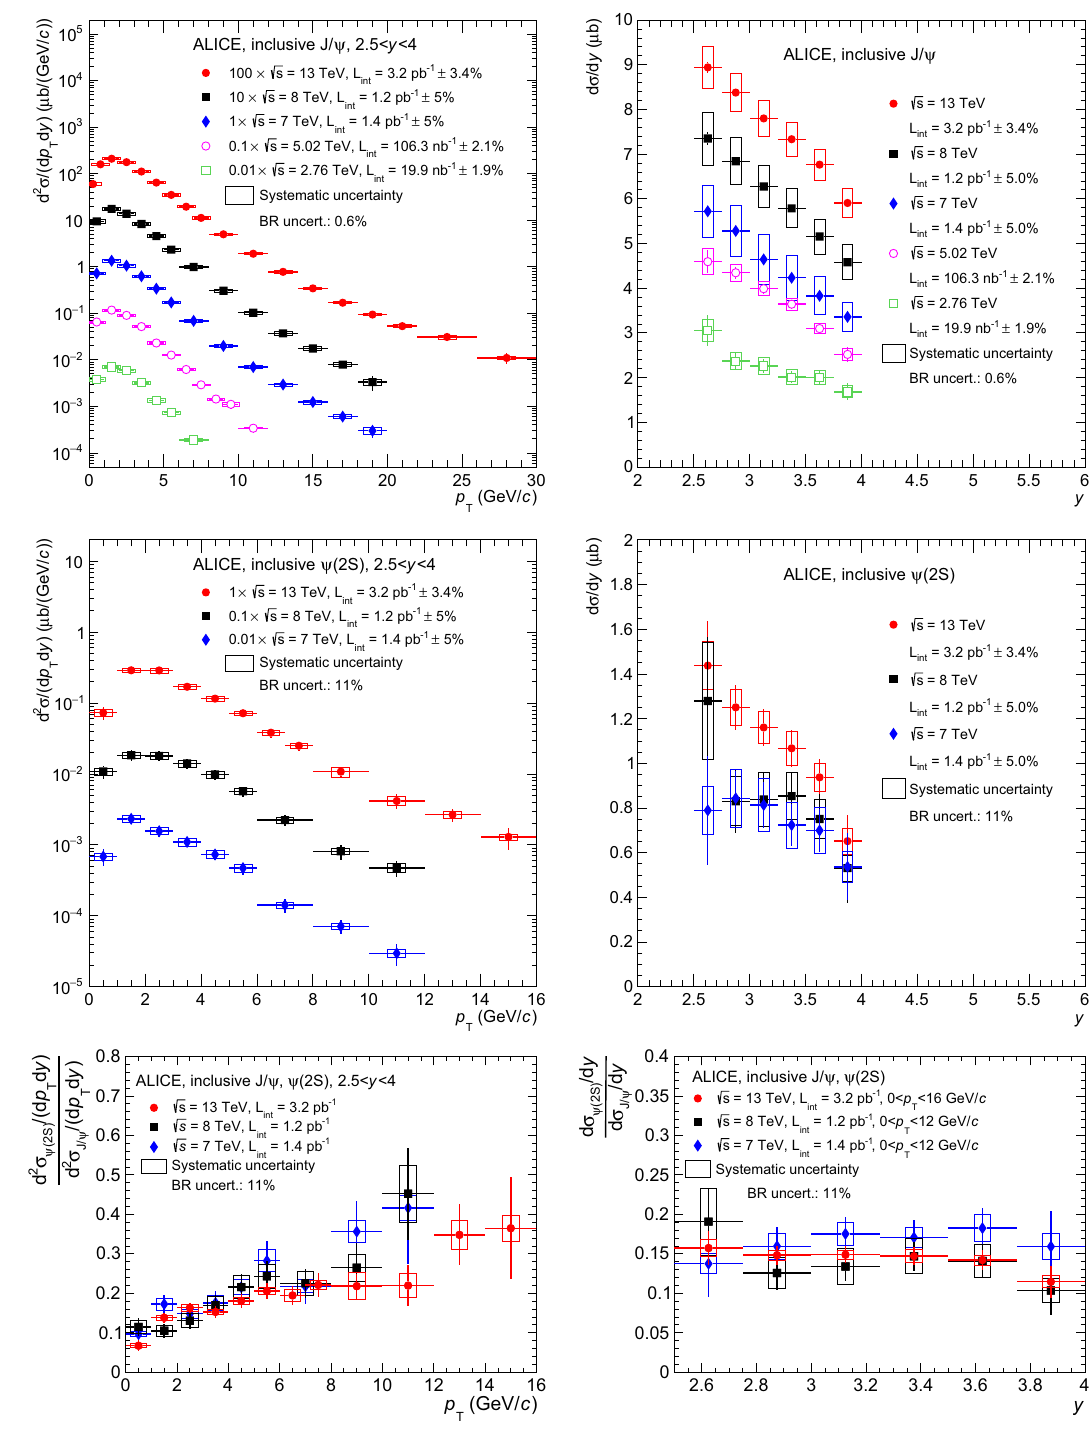
Fig. 4 Inclusive J /ψ cross sections ( top ), ψ( 2S ) cross sections ( middle ) and ψ( 2S ) -to-J /ψ cross section ratios ( bottom ) as function of p t ( left ) √ s and y ( right ) in pp collisions at several values of